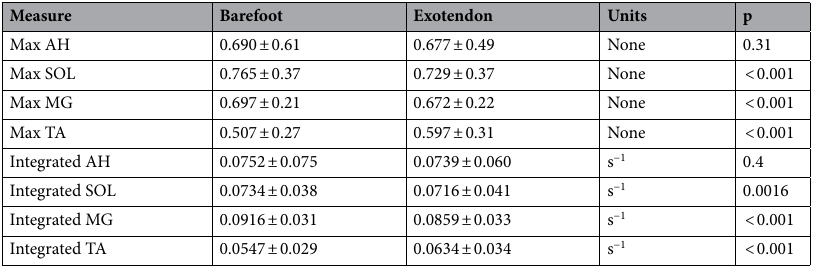
Table 3. Peak and integrated EMG measures presented are averaged across all participants and are presented in the format mean ± standard deviation for the barefoot and exotendon conditions. The 5th column has the p-value for the fixed efficient coefficient for the exotendon condition in the linear mixed effects model, where p < 0.05 was considered